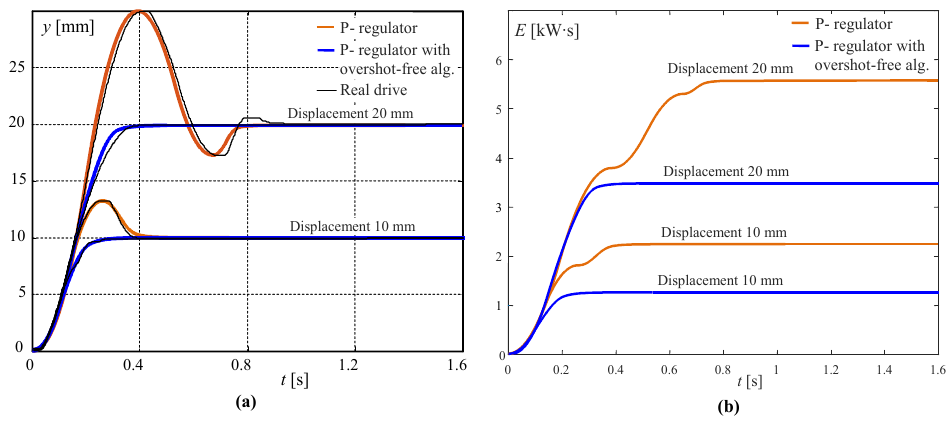
Figure 12. The servo drive with two stepping motors and its model step (color curves: brown and blue) responses. ( a ) With P-type controller. ( b ) With P-type and overshot-free algorithm.